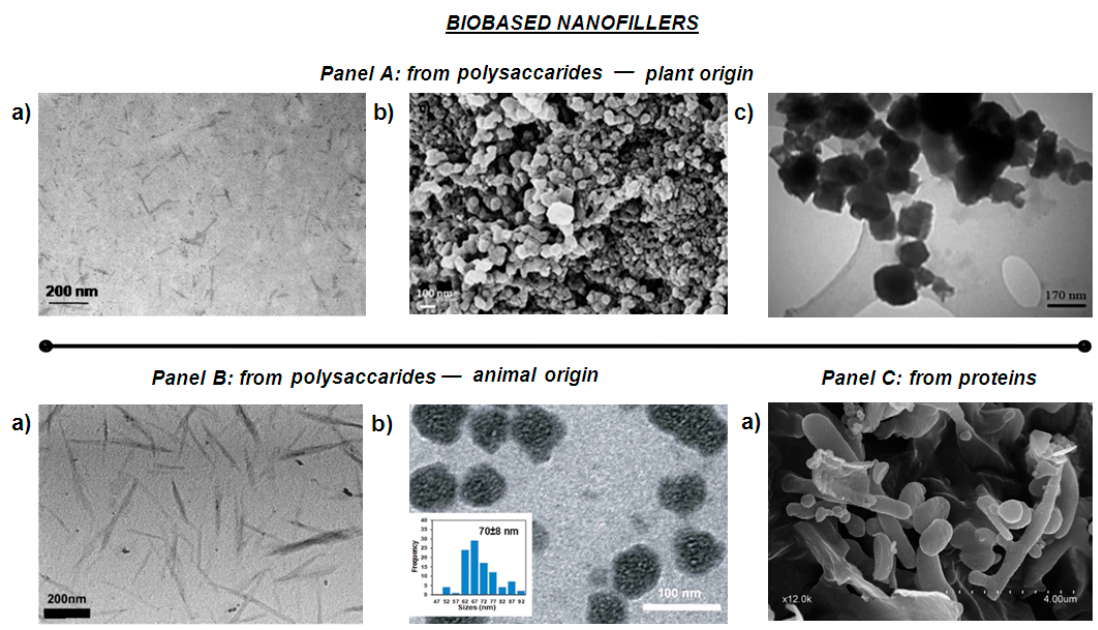
Figure 1. Morphological characterization of bio-based nanofillers. Panel A: Polysaccharides—plant origin: ( a ) Transmission Electron Microscopy (TEM) image of Cellulose Nanocrystals CNC [27]; ( b ) Field Emission Scanning Electron Microscopy (FESEM) image of lignin nanoparticles [34]; ( c ) TEM image of starch nanoparticles [35]. Panel B: Nanofillers from Polysaccharides—animal origin: ( a ) TEM image of Chitin nanocrystals [36], ( b ) TEM image of modified chitosan nanoparticles (CSNP) by poly (ethylene glycol) methyl ether methacrylate (PEGMA) (PEGMA-graft-CSNP) [37]. Panel C: From proteins: ( a ) Scanning Electron Microscopy (SEM) image of nanokeratin [38].